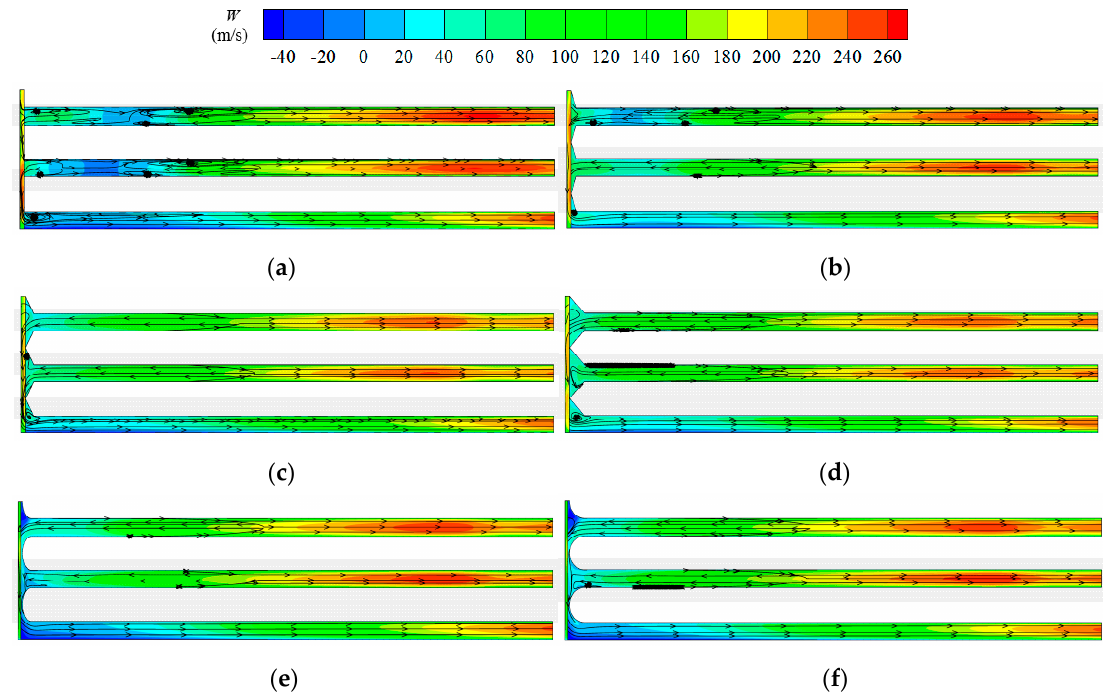
Figure 18. Streamlines and relative tangential velocity distributions on the radial cross-sections of 45° for different turbine models. ( a ) OTM-B; ( b ) OTM-T-1; ( c ) OTM-T-2; ( d ) OTM-T-3; ( e ) OTM-C-2; ( f ) OTM-E-3.